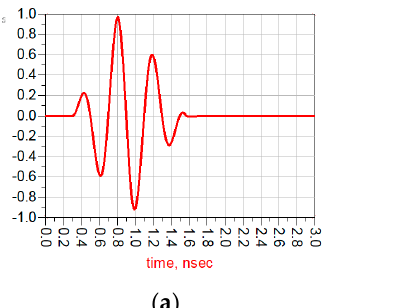
Figure 18. ( a ) Generated pulse, ( b ) its spectrum in ADS.